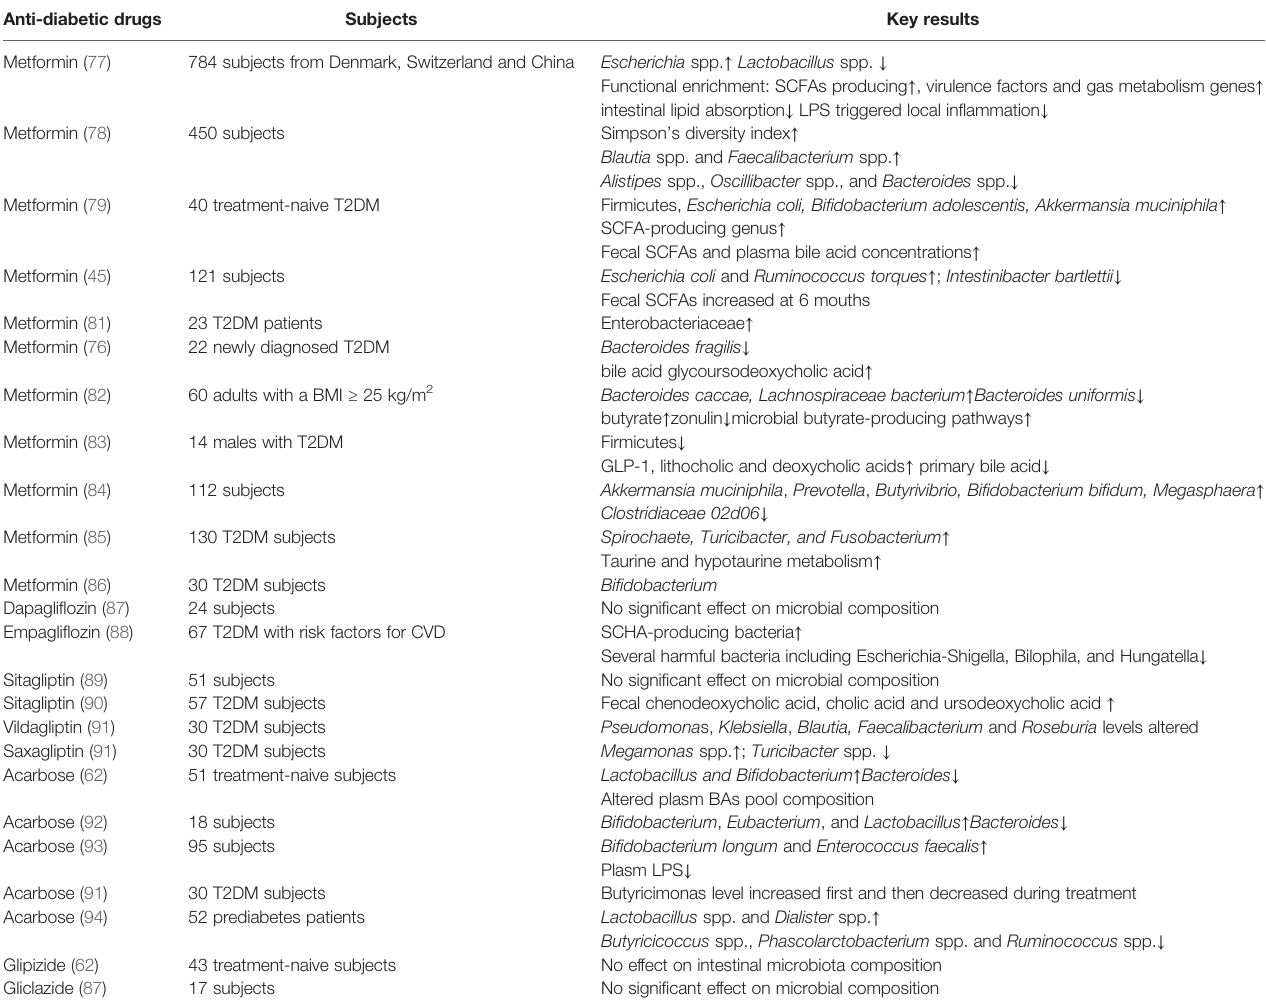
TABLE 1 | Clinical research exploring the effects of oral anti-diabetic drugs on gut microbiota in T2DM. Anti-diabetic drugs